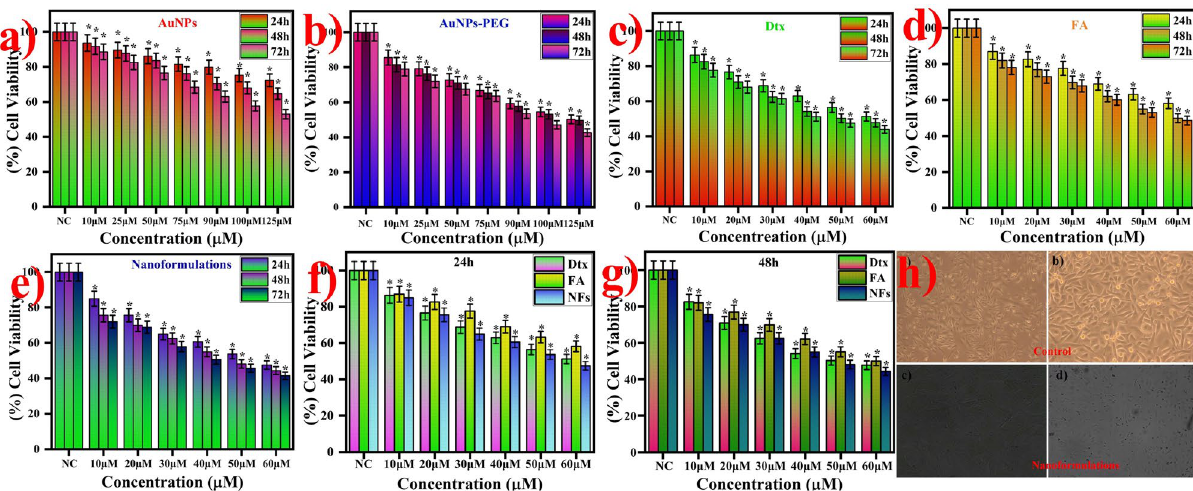
Figure 10. In vitro cytotoxicity analysis of gold nanoformulations against PC3 cell lines at different time intervals such as 24 h, 48 h, and 72 h using premix WST cell proliferation assay kit. ( a ) AuNPs, ( b ) PEG-AuNPs, ( c ) Dtx, ( d ) FA ( e ) AuNPs nanoformulations and ( f , g ) Comparison between Dtx, FA and nanoformulations at 24 and 48 h post treatment, and ( h ) PC3 cell images at control and nanoformulations. [*Corresponds to the statistical significance values (p <